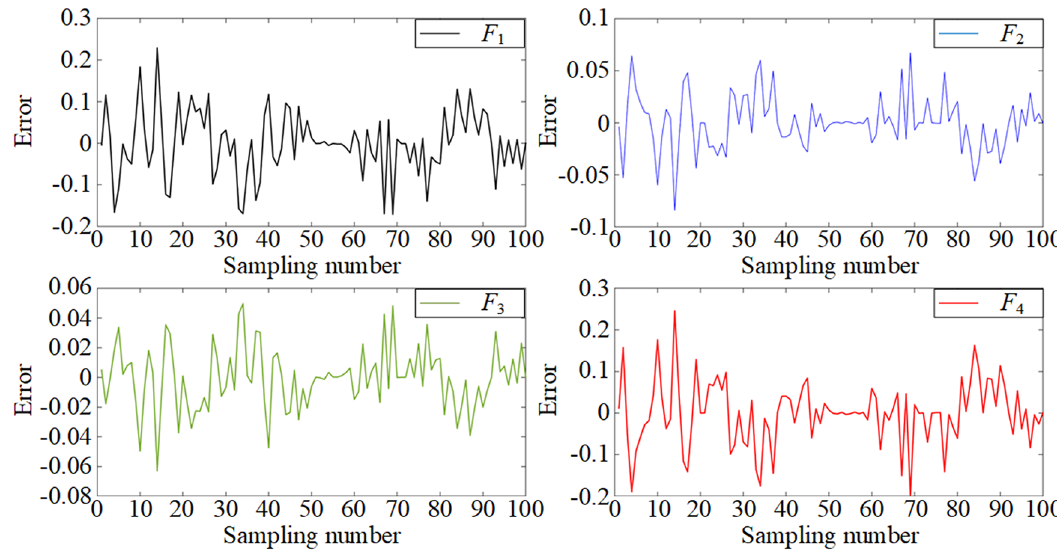
Fig. 18. Error between predicted value and expected value. Table 3. Average value and RMS values of the error between predicted and expected